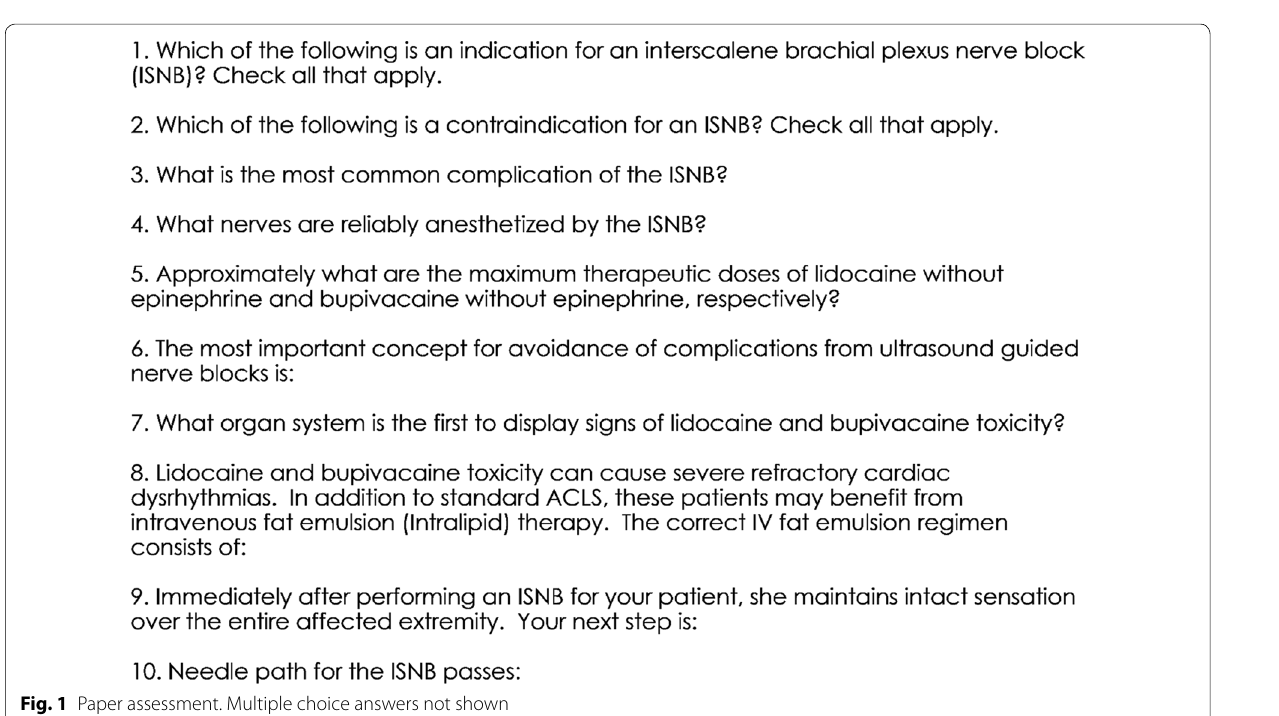
Fig. 1 Paper assessment. Multiple choice answers not